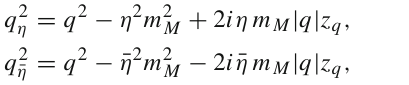
Fig. 2 The integration domain defined by the BSE for a meson of mass m M described by a parabola in the complex q 2 η